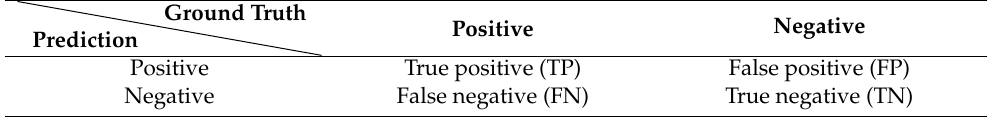
Table 3. TP, FP, TN and FN performance metrics.